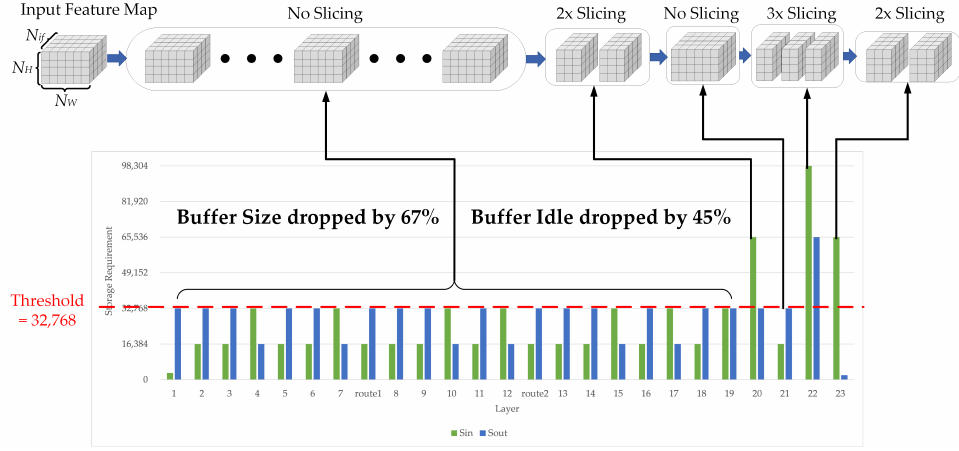
Figure 8. The dynamic slicing strategy for the improved